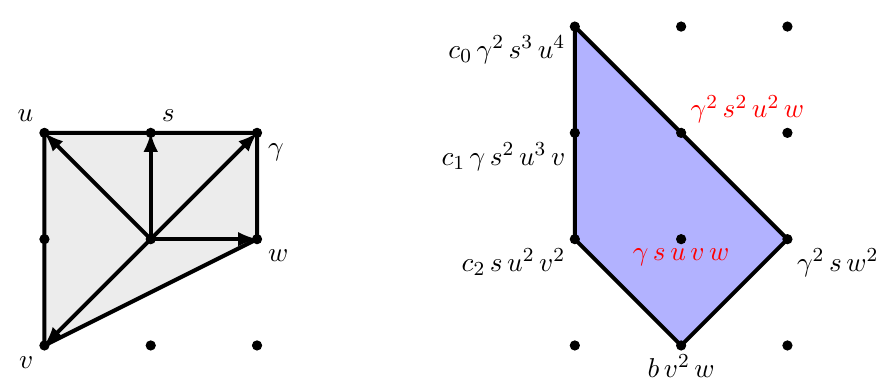
Figure 2 . On the left : the toric polygon, called F 8 in [28], of the (cid:13) -blow-up of Bl 1 P 112 . On the right : the dual polygon, giving rise to the hypersurface equation for ^ Y F the vertex of the dual polygon corresponding to the c 3 -term of the U(1) model (3.1). As discussed in [28], this elliptic (cid:12)bration has an I 2 locus above b = 0. Were it not for a unit coe(cid:14)cient in front of (cid:13) 2 s w 2 (which allows us to absorb the red terms), there would be another I 2 locus present. The non-toric tuning c 1 ! 0 enhances the U(1)